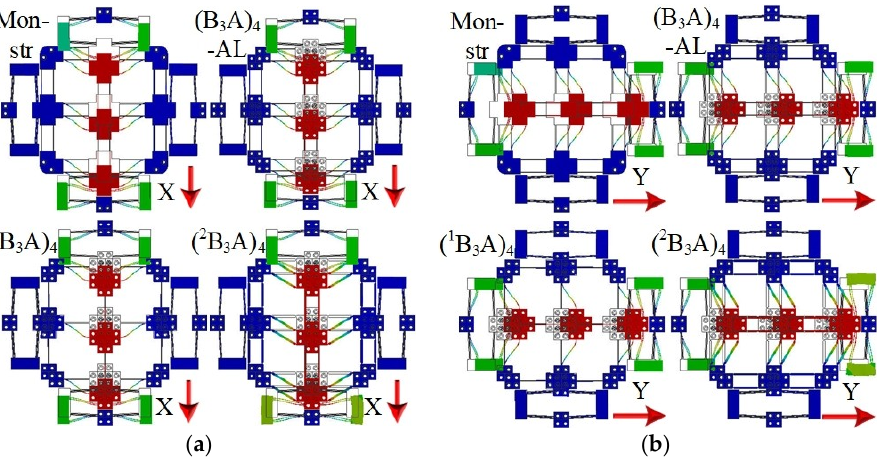
Figure 13. Displacement simulation results of the XY MPSs: ( a ) the output along the X axis; ( b ) the output along the Y axis. Table 3. Analysis results of different decoupled parallel XY MPSs.